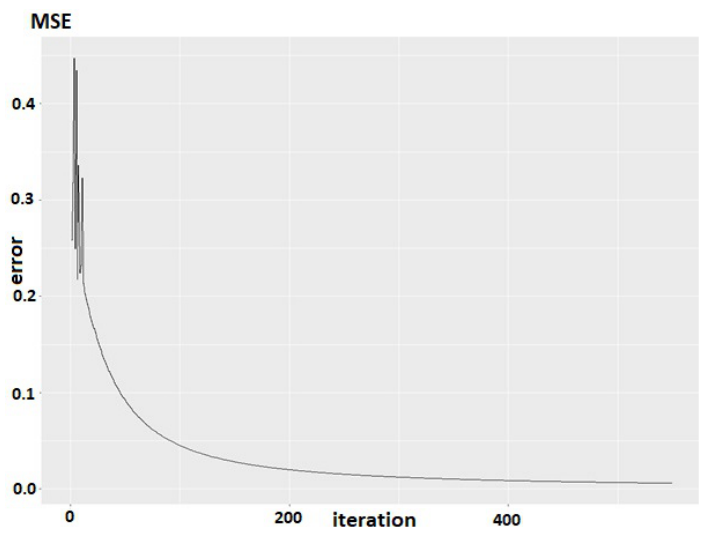
Figure 14. Fuzzy network 4—learning